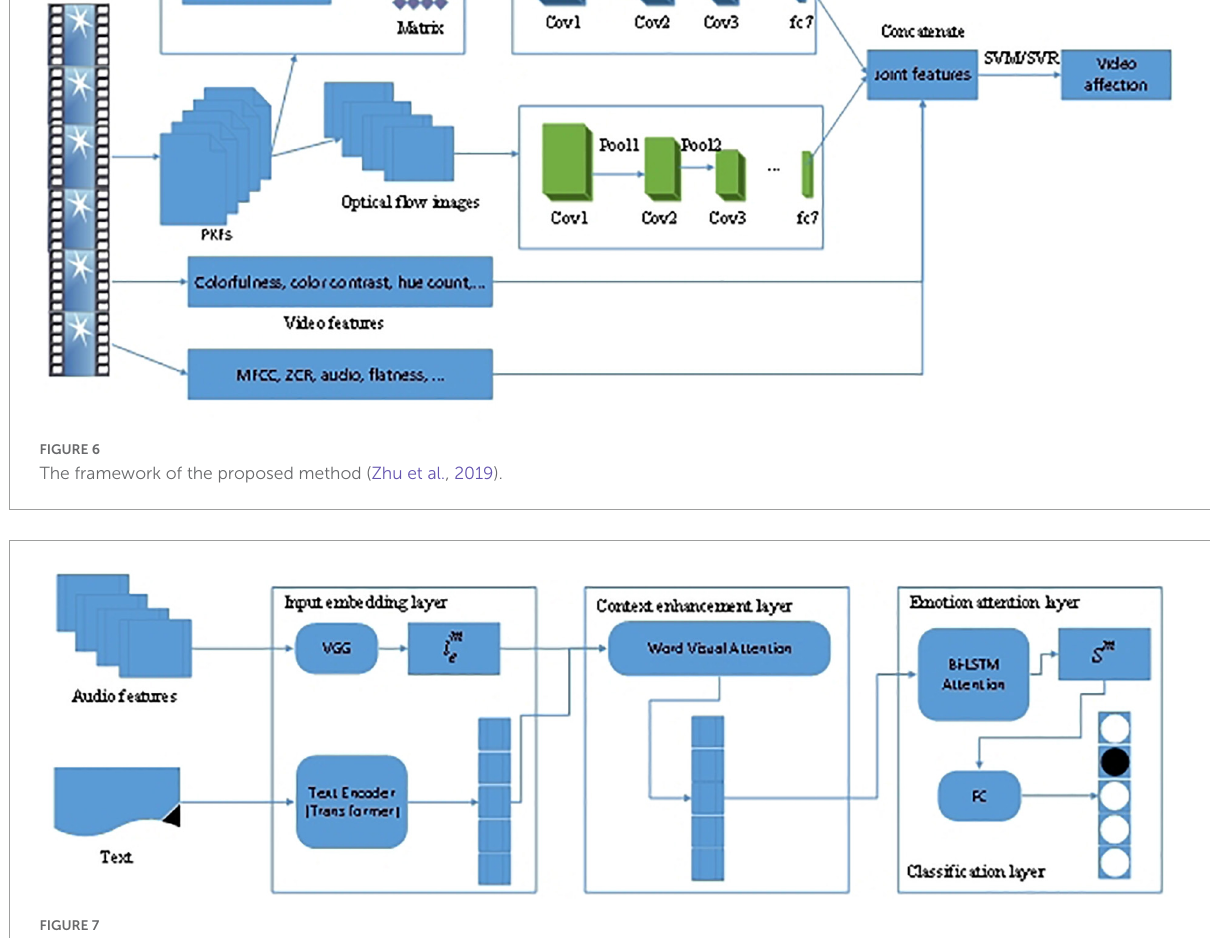
FIGURE7 The architecture of VECERM (Cao et al.,